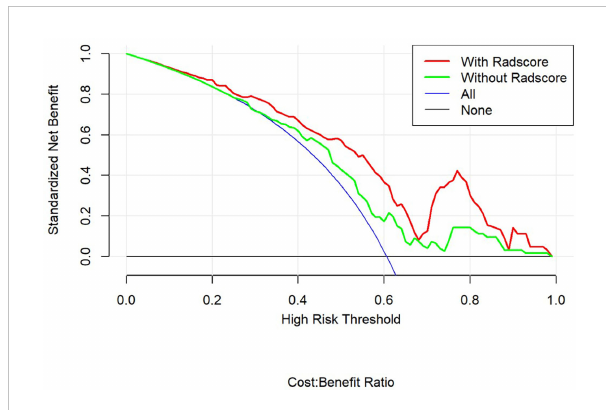
FIGURE 4 Decision curve analysis for the combined and clinical